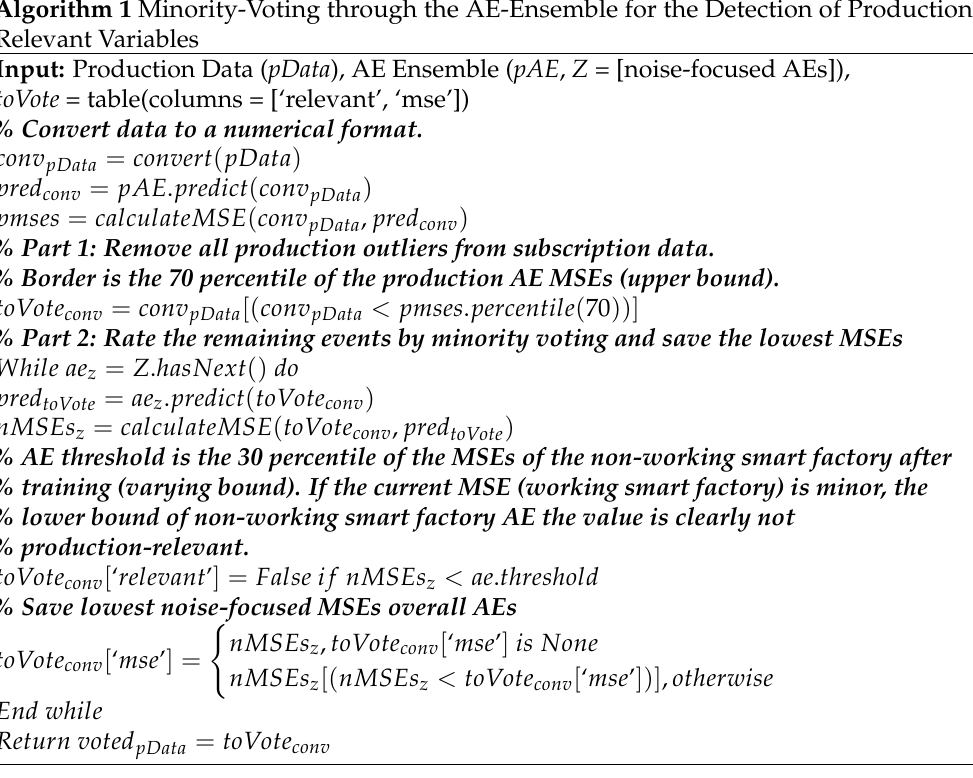
Algorithm 1 Minority-Voting through the AE-Ensemble for the Detection of Production- Relevant